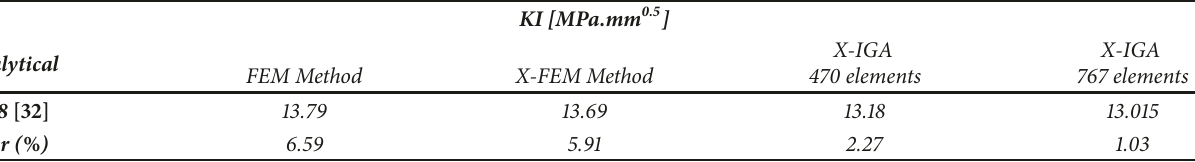
Table 3: Comparison of the KI factors between the proposed method of X-IGA and the analytical, FEM, and X-FEM methods for the case of a crack with a = 5 mm.